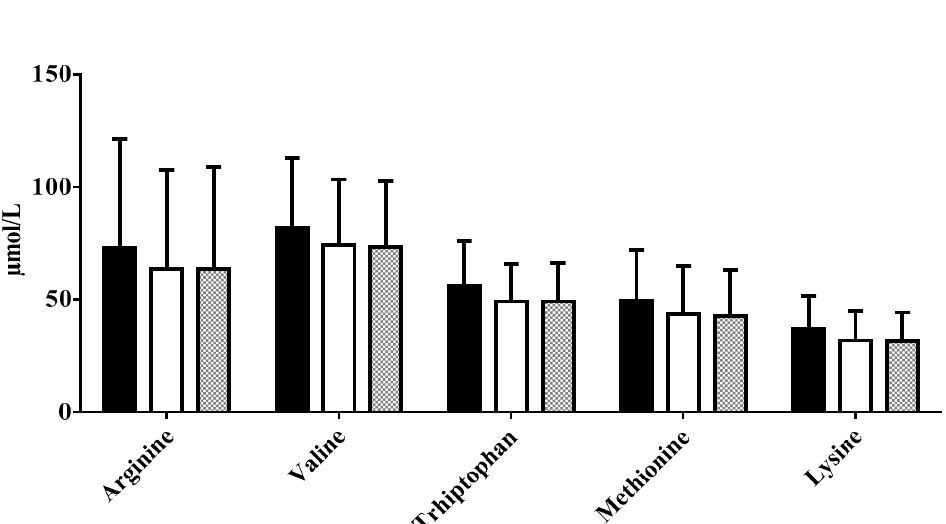
Figure 5. Amino acids concentration in not pasteurized, pasteurized by Holder method, and pasteurized by modified Holder method aliquots. NP—not pasteurized; HoP—Holder pasteurization; MHoP—modified Holder pasteurization.